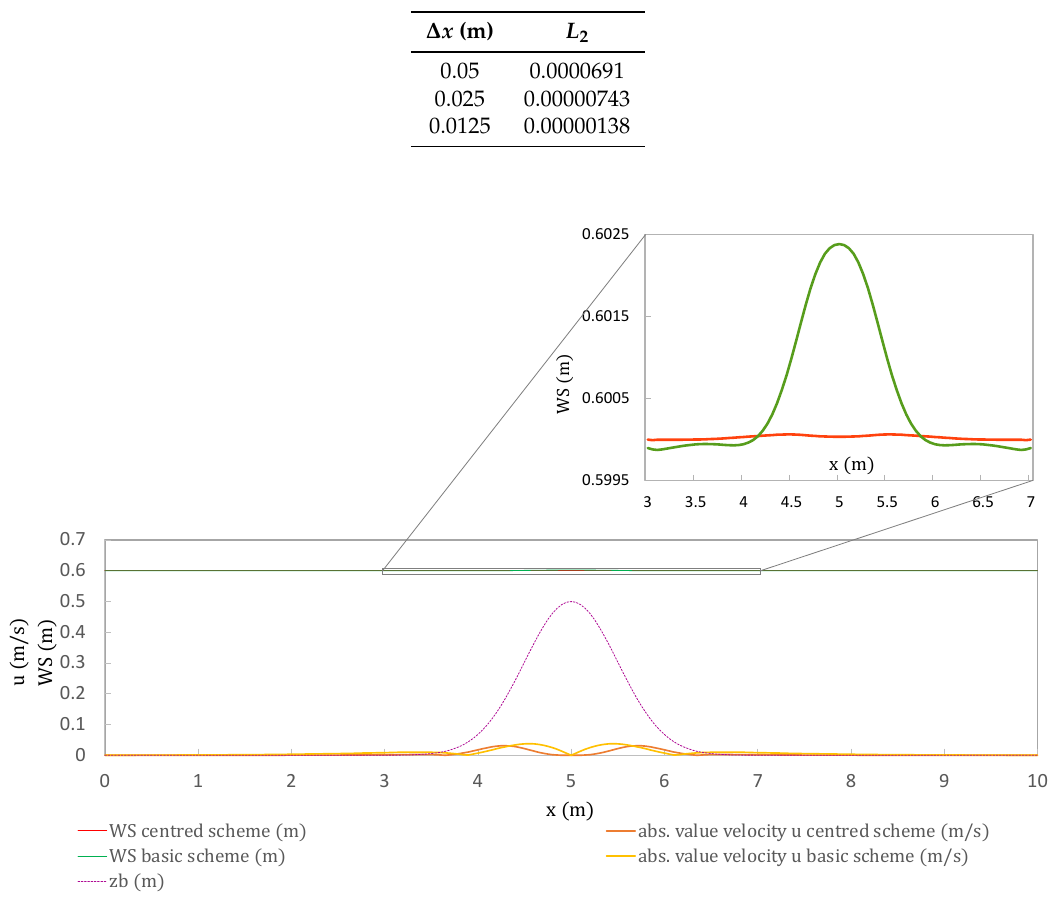
Table 3. WS L 2 norms—correspondence of numerical results with analytical solution.